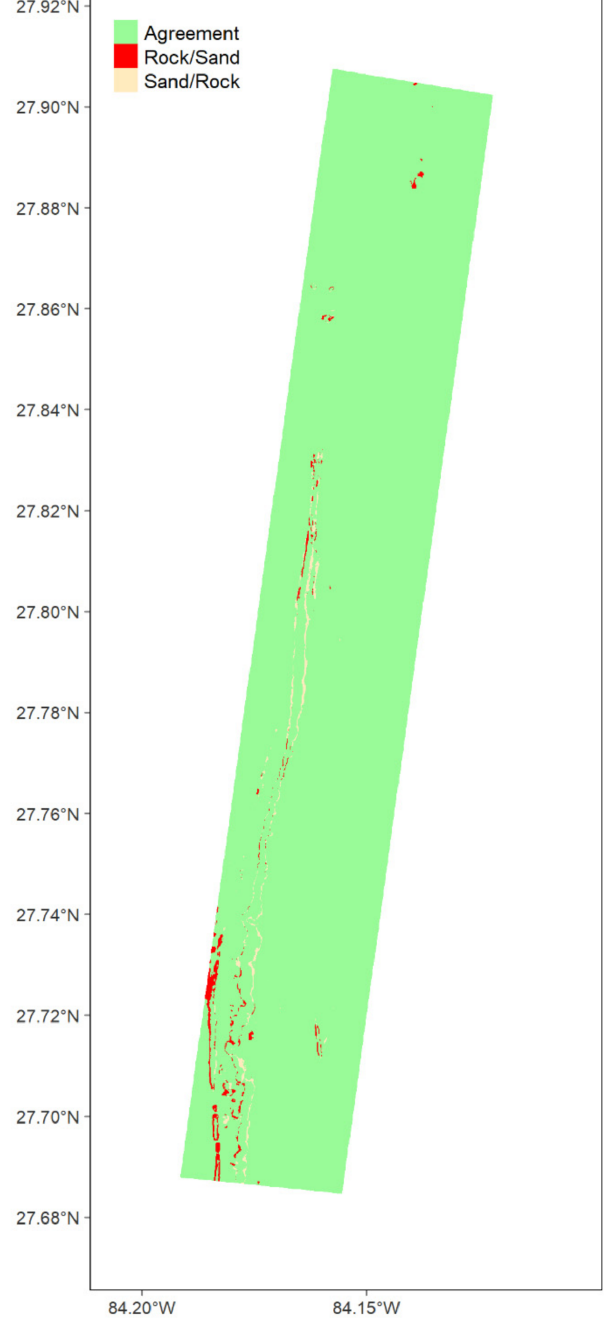
Figure 11. Difference map showing where the modeled predictions of substrate agreed and disagreed for the supervised and the unsupervised classification models. For disagreement, the legend is formatted with the supervised/unsupervised model